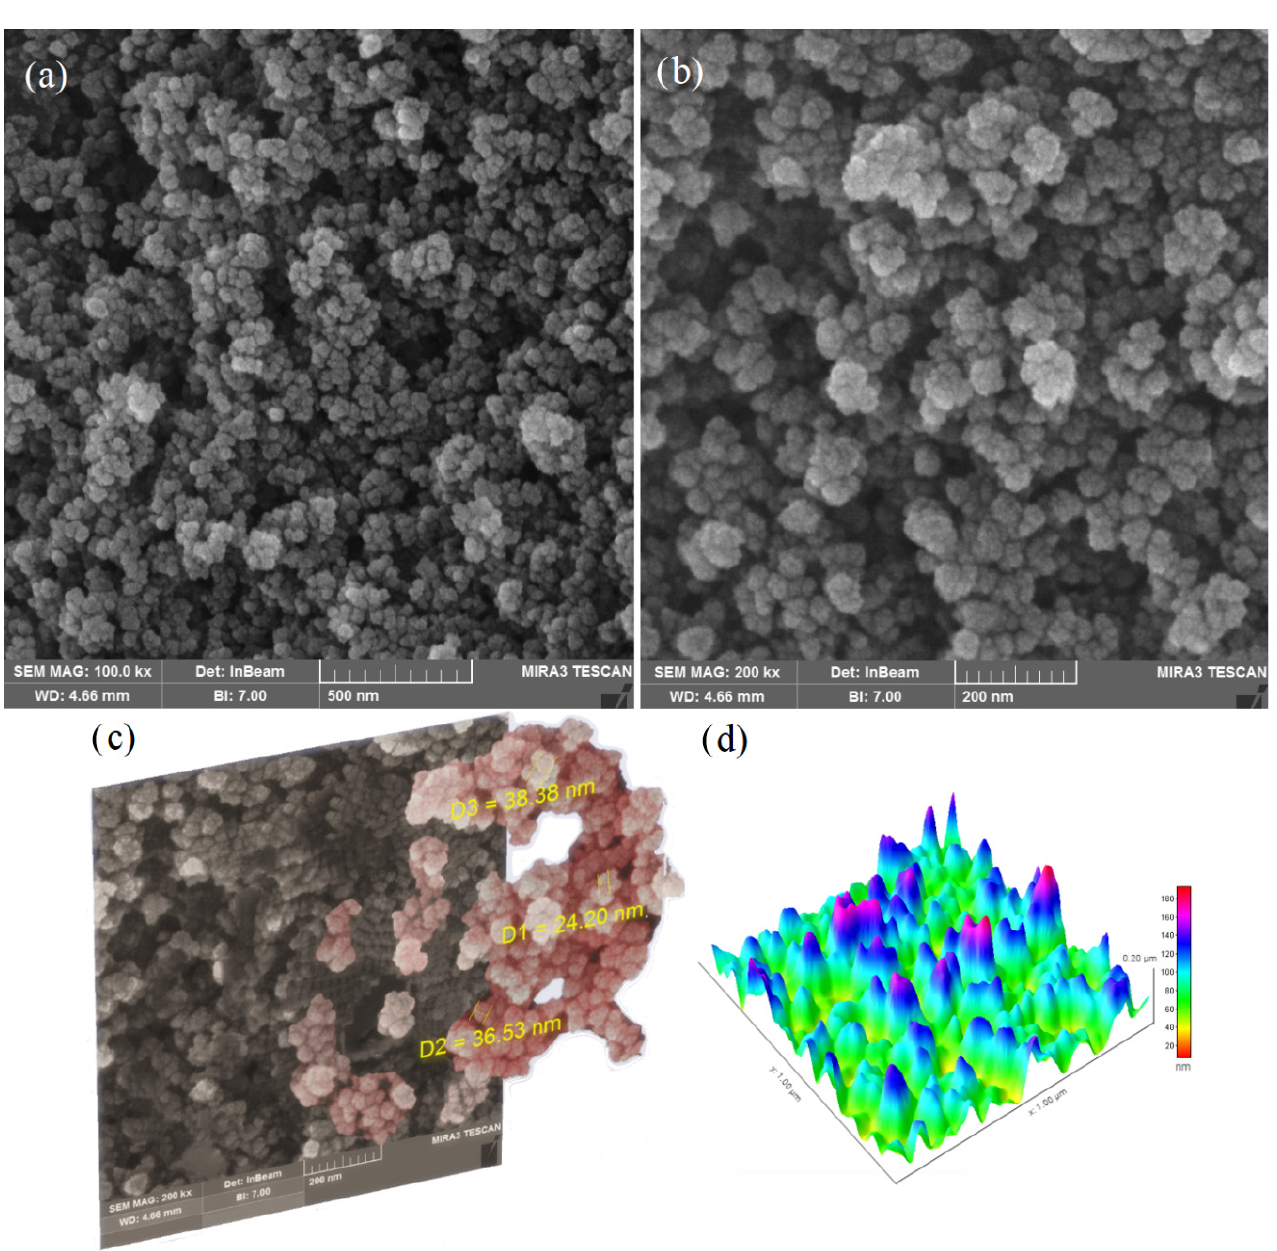
Figure 3. Imageanalysis ofbitumenmodified withfumedsilica NPs: ( a , b )FESEM; ( c )FESEM process; and ( d )surface Figure 3. Image analysis of bitumen modified with fumed silica NPs: ( a , b ) FESEM; ( c ) FESEM process; and ( d ) surface morphology.